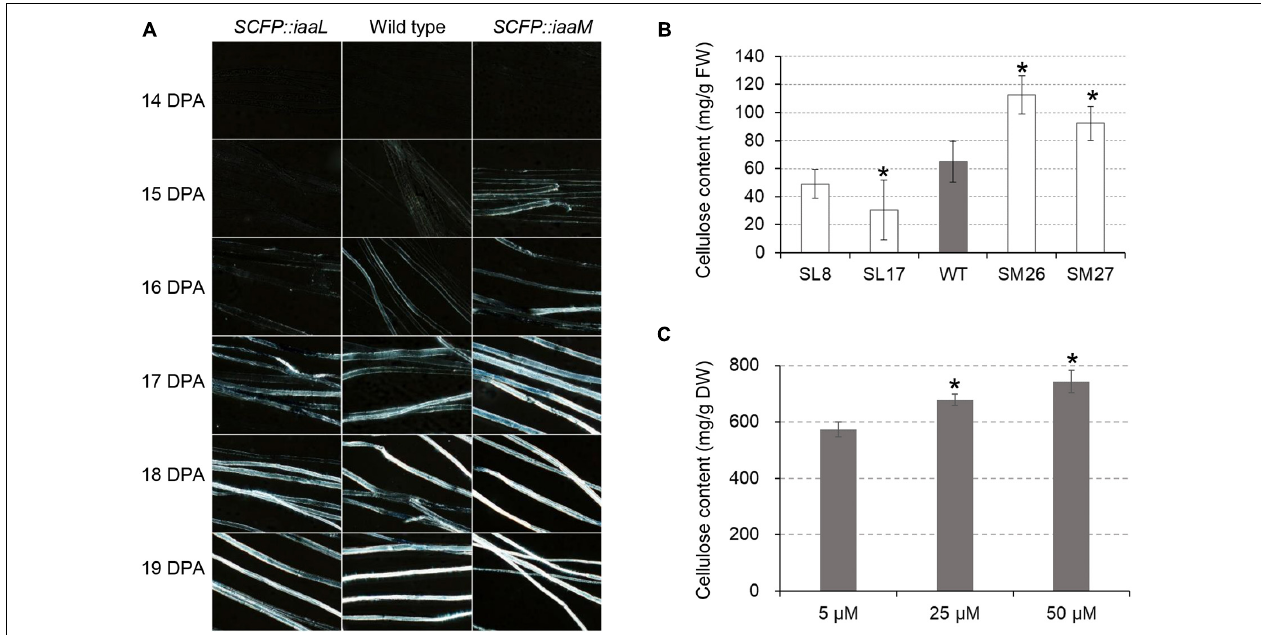
FIGURE 5 | Auxin promotes the onset of cellulose deposition in cotton fibers. (A) Cellulose deposition in developing fibers. (B) Cellulose content in cotton fibers at 15 days post-anthesis (DPA). (C) Cellulose content in IAA-treated fibers. Ovules (0 DPA) were cultured in vitro for 30 days. WT, wild-type; SM, SCFP:iaaM transgenic cotton; SL, SCFP:iaaL transgenic cotton. Error bars indicate standard deviation based on three biological replicates. Asterisks indicate significant difference (vs. wild-type or 5 µ M) as determined by Student’s t -test ( P < 0.05).